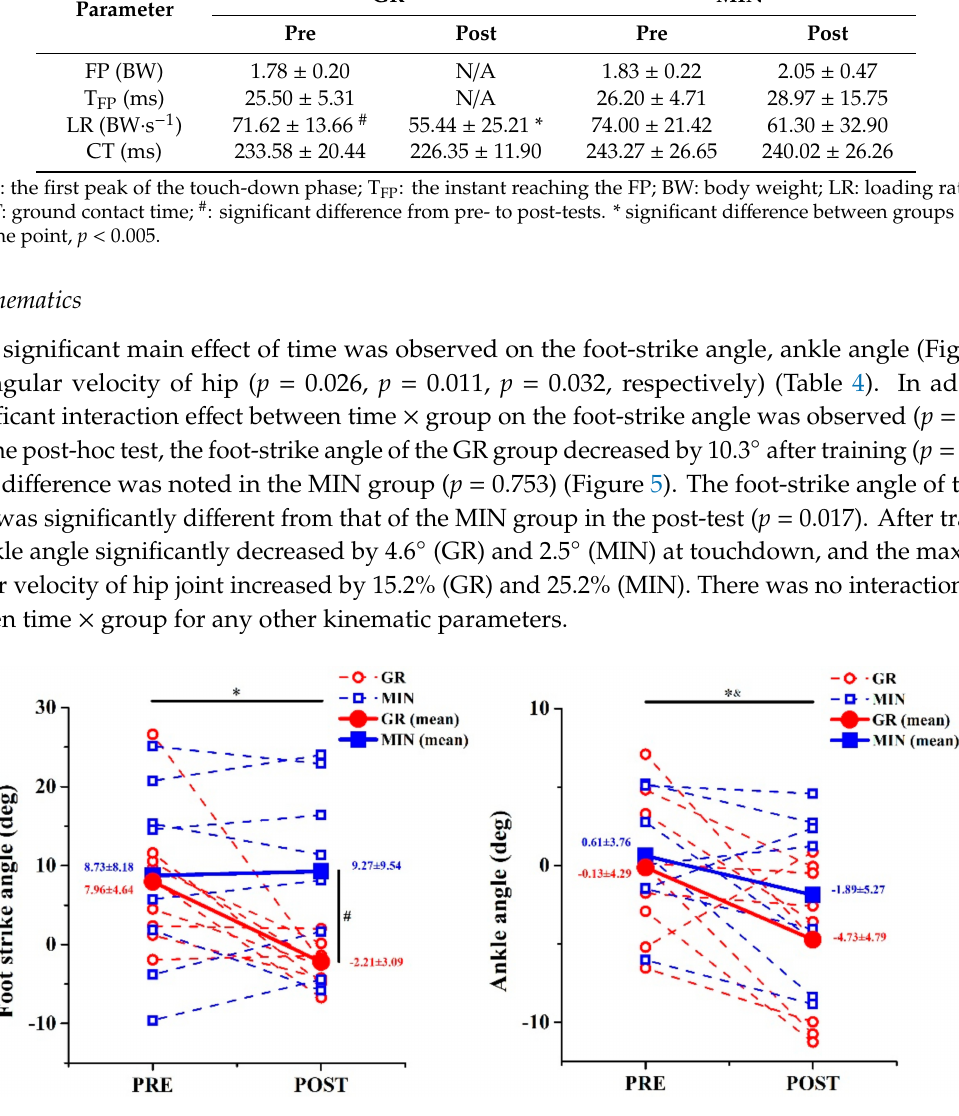
Table 3. Contrast of ground reaction force (GRF) in di ff erent shoe conditions before and after training. Parameter